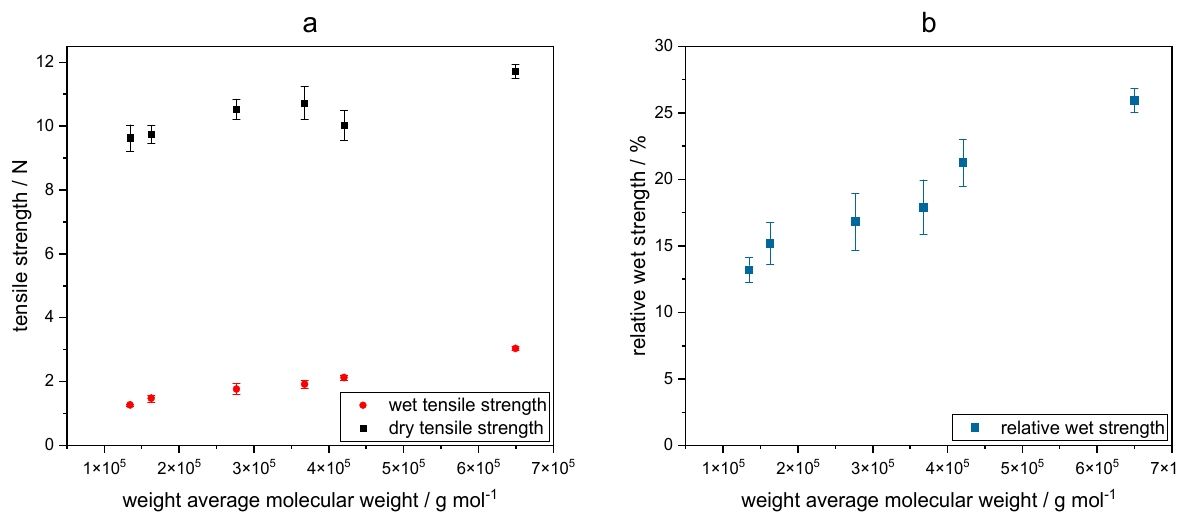
Figure 8. Influence of the weight average molecular weight of keto-HPC DOx1.5 in combination with PEI on dry and wet tensile strength ( a ) and relative wet strength ( b ) applied to cotton linter paper with a polymer amount of 1.5 wt%.